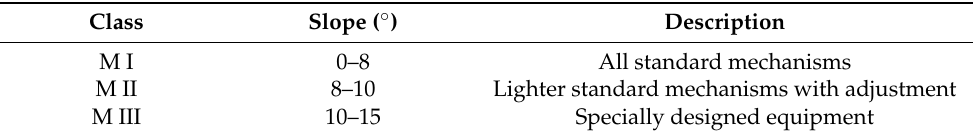
Table 4. Mechanization accessibility classes.